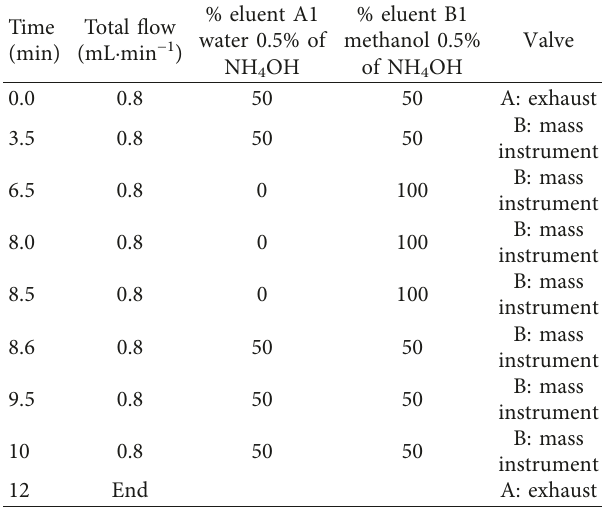
Table 1: Elution conditions employed in SPE online column.